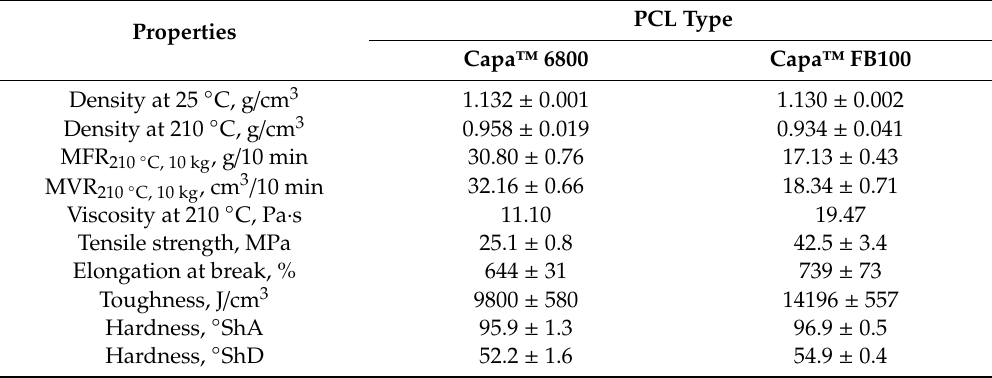
Table 1. Properties of the used poly( ε -caprolactone) (PCL)